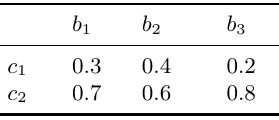
Table 1: An example of P(C | B) for the variable C in Figure